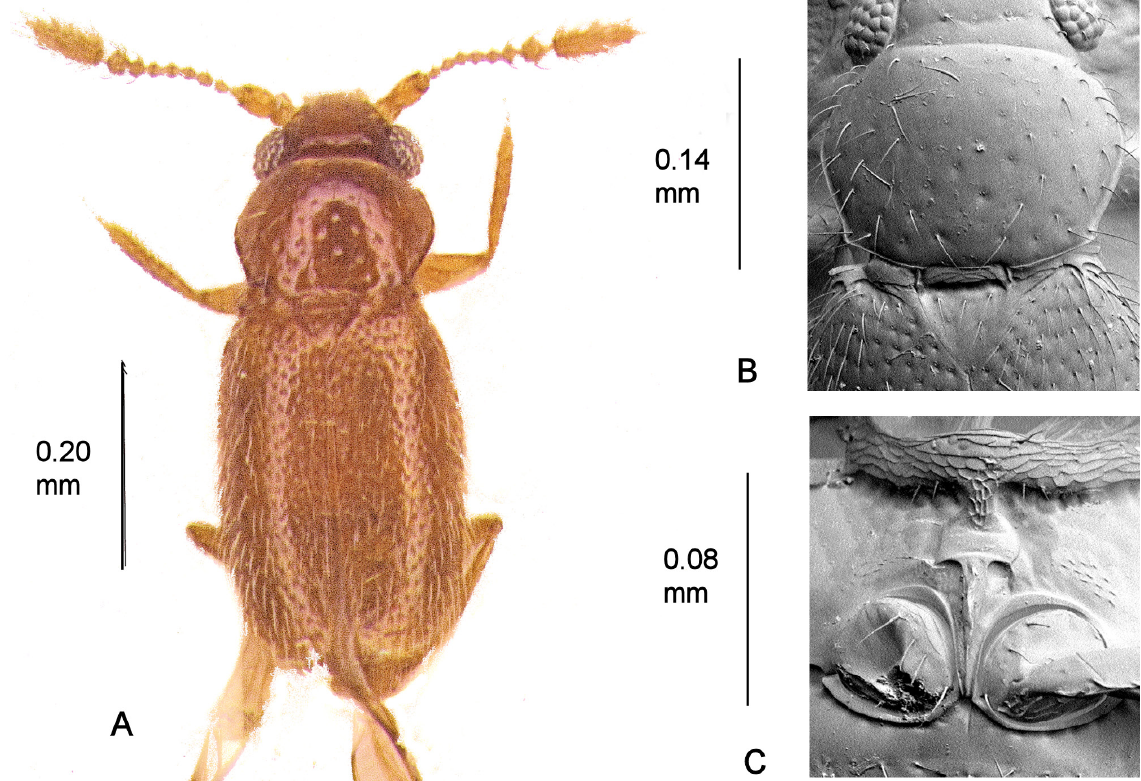
Fig. 65 . Cissidium besucheti sp. nov. A . Habitus. B . Pronotum, × 755. C . Mesoventrite showing median process of collar, mid-keel and keel, ×